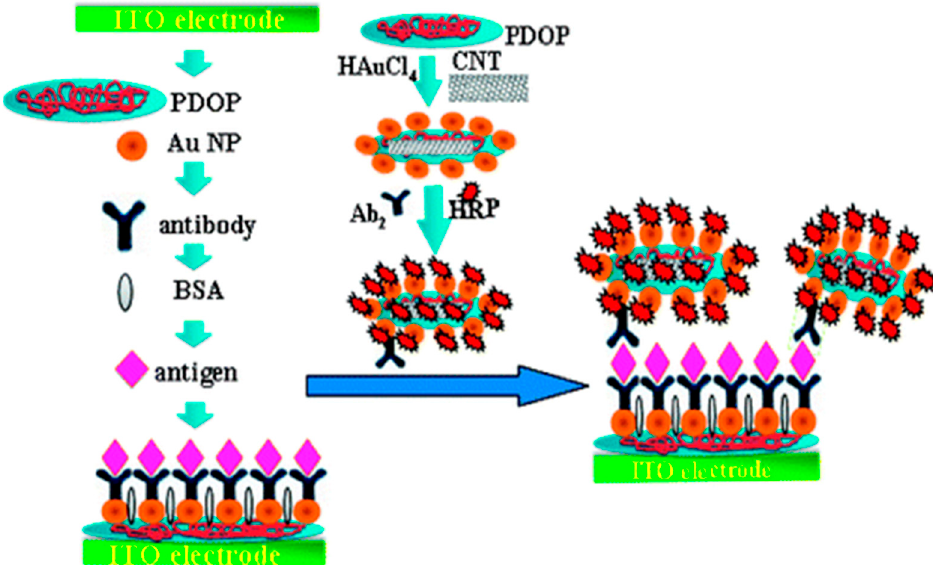
Figure 5. Preparation of ITO/PDOP-AuNP/Ab 1 platform and HRP-Ab 2 -AuNP-PDOP@CNT Probe and sandwich type immunoassay. IL-6 binds to Ab 1 and Ab 2 and immobilizes HRP, which oxidizes 1,2-phenylenediamine in the presence of H 2 O 2 . Reprinted from [111] with permission from American Chemical Society.